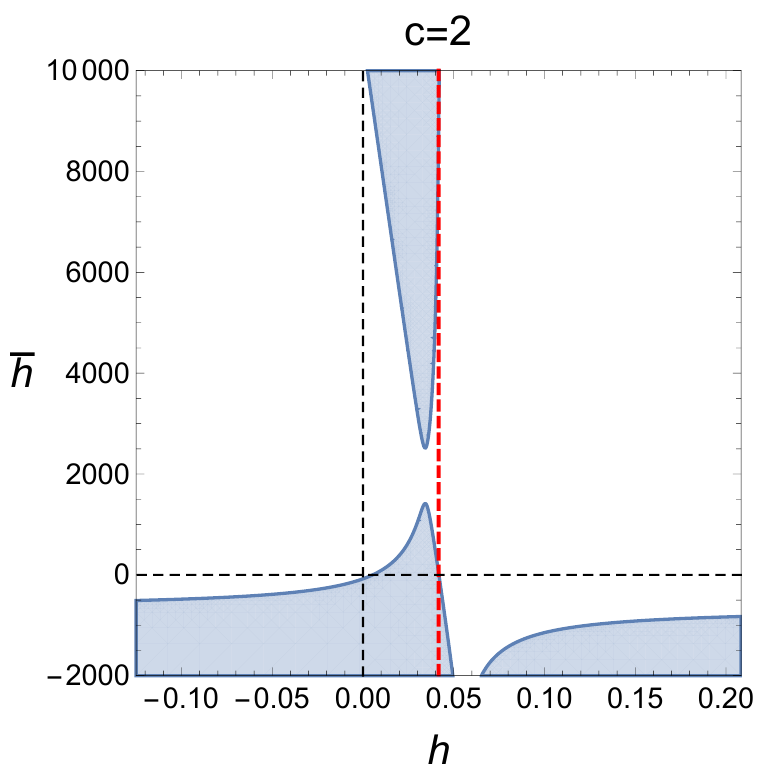
Figure 3: Deriving the twist gap. The shaded regions are where the functional (4.10) is negative, for c = 2. The expected upper bound ( c − 1 ) / 24 is denoted by the dashed = 100 π . There must be a state in the shaded red line. We have taken q = 24 and β L regions with h and h positive. We have shown the unphysical quadrants with negative h and h to exhibit a more complete picture of the